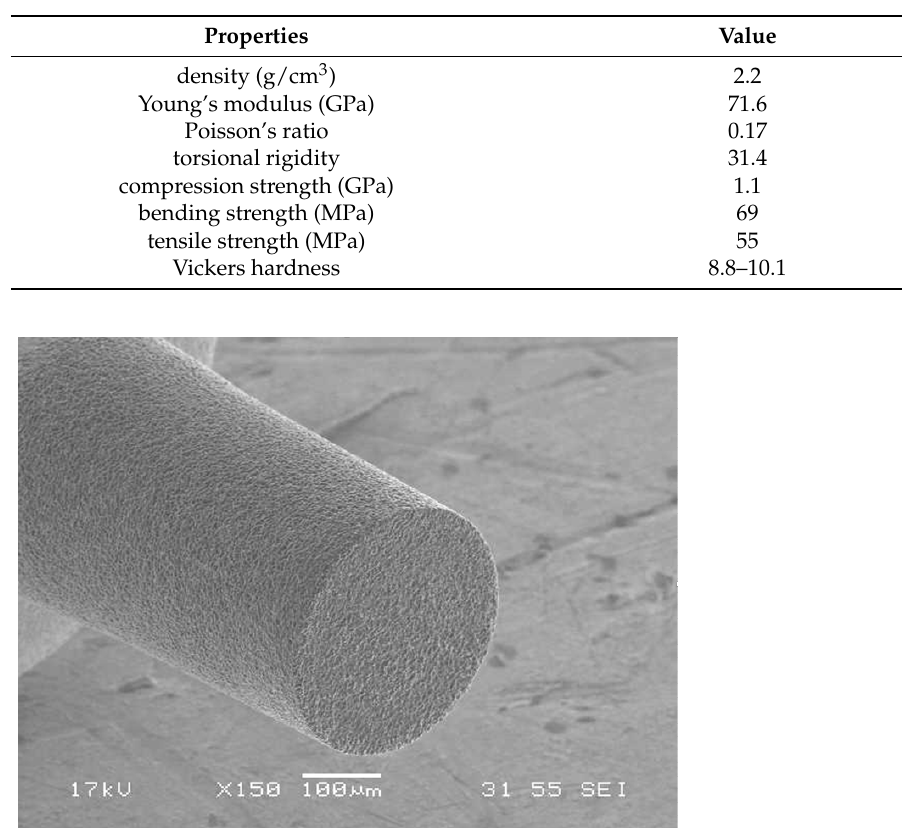
Figure 1. The microgrinding system. Table 1. The physical properties of the fused silica. Table 1. The physical properties of the fused silica.